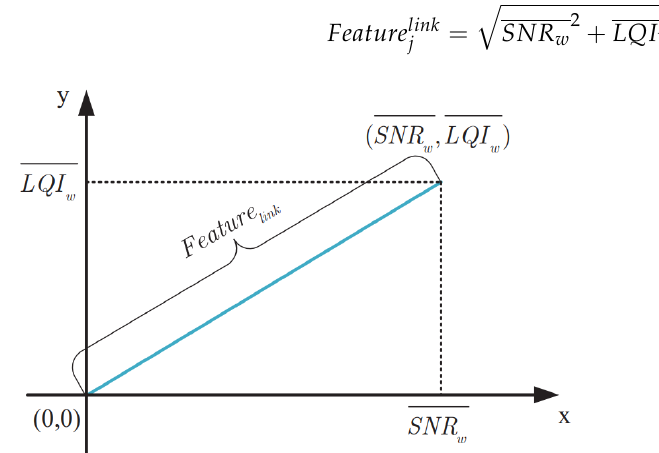
Figure 3. Link information